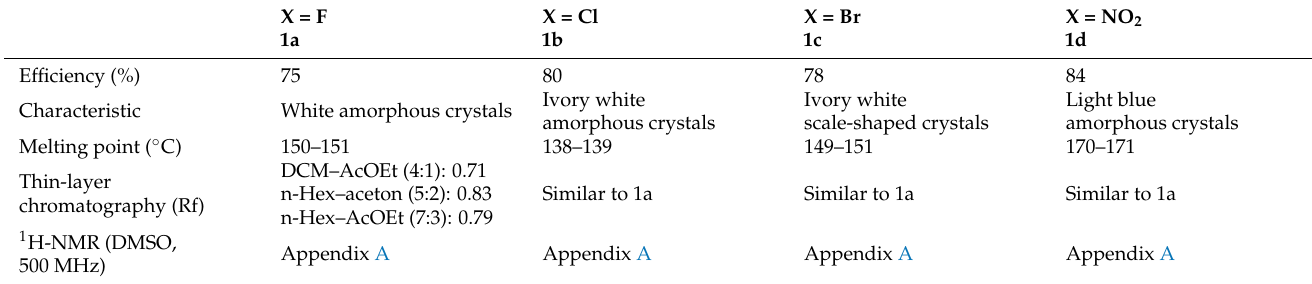
Figure 1. 2-methyl-3-p-substitutedphenyl-4( 3H )-quinazolinone derivatives ( 1a–d ) (X = F, Cl, Br, NO 2 ). Table 1. Properties of the synthesized 2-methyl-3-p-substitutedphenyl-4( 3H )-quinazolinone deriv- atives ( 1a–d ).